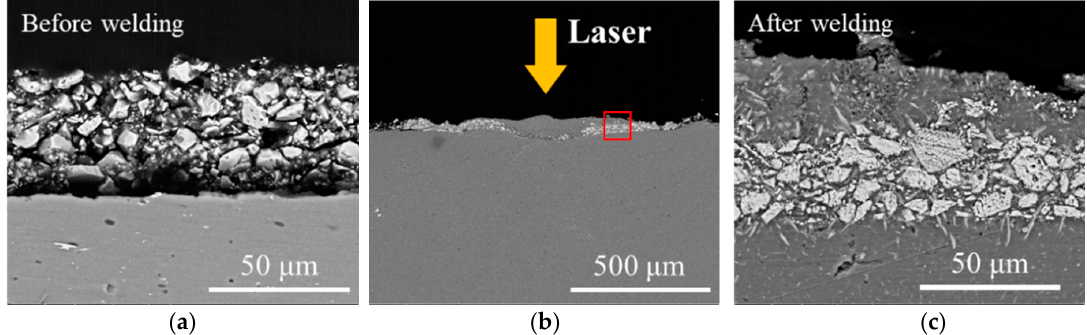
Figure 5. Images of TiN-coated BM ( a ) before laser welding and ( b ) and ( c ) after laser welding.